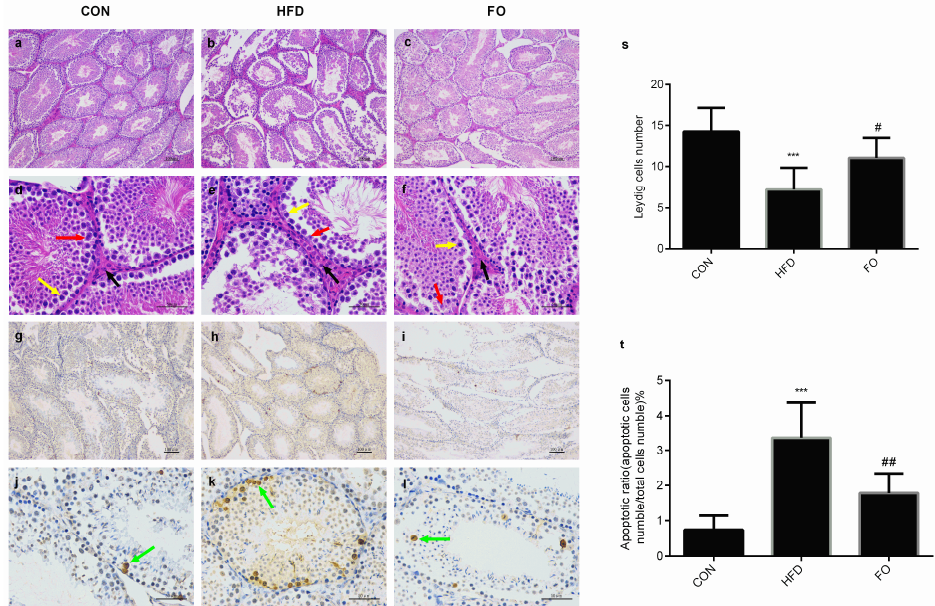
Figure 3. Hematoxylin–eosin (HE) and terminal deoxynucleotidyl transferase-mediated dUTP nick end labeling (TUNEL) staining of testes. Testes tissue sections were stained with HE staining ( a – f ) and TUNEL staining ( g – l ) respectively and quantitative analysis of the Leydig cells ( s ), apoptosis index ( t ). The representative photographs as follow: ( a – c ) H&E staining of the CON, HFD and FO group testes sections (scale bar 100 µm), respectively; ( d – f ) H&E staining of the CON, HFD and FO group testes sections (scale bar 50 µm), respectively; ( g – i ) TUNEL staining of the CON, HFD and FO group testes sections (scale bar 100 µm), respectively; ( j – l ) TUNEL staining of the CON, HFD and FO group testes sections (scale bar 50 µm), respectively. Black, red, yellow, green arrow indicates the Leydig cell, sertoli cell, spermatozoa cell, apoptotic cell, respectively. Data were expressed as mean ± SD ( n = 10 per group). *** p < 0.001 vs. CON group; # p <0.05, ## p < 0.01 vs. HFD group.